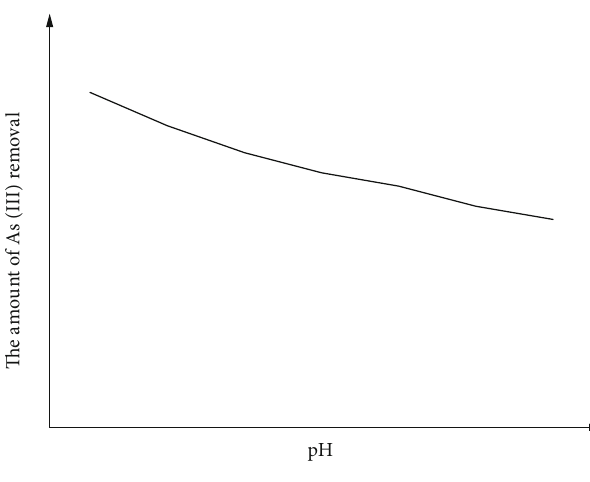
Figure 1: As removal in